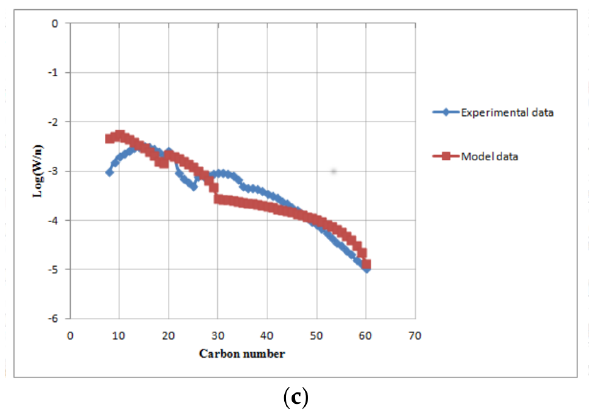
Figure 6. The comparison of the predicted model with experimental data at change load conditions (volumetric gas flow rate 3.5 m 3 /h, T = 503 K, ε cat = 0.34, P = 20 bar): ( a ) off-gas molar fractions; ( b ) FT products (naphta, diesel, wax); ( c ) ASF distribution.